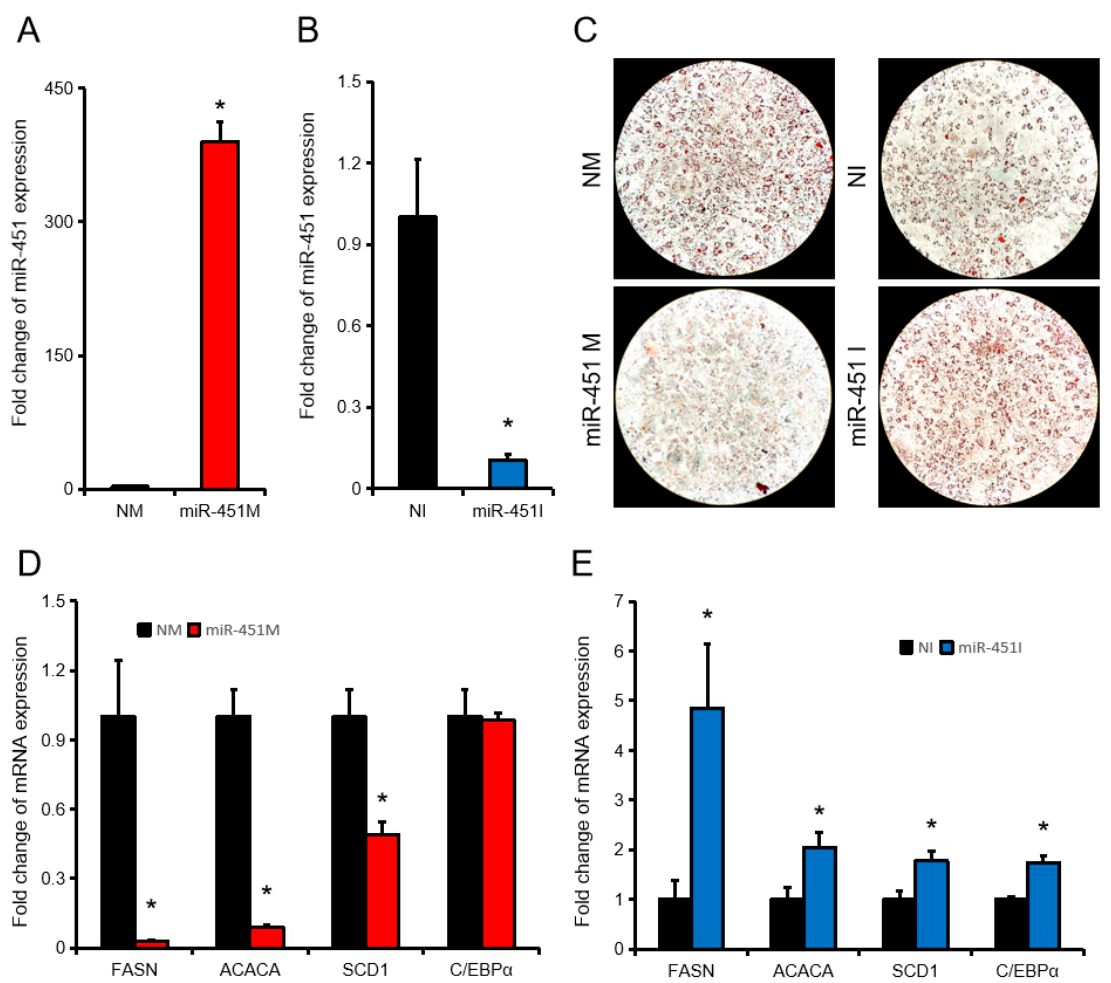
Figure 2. ssc-miR-451 regulates the differentiation of porcine primary adipocytes. ( A , B ) miR-451 expression in porcine primary adipocytes after transfection with miR-451 mimic ( A ) and inhibitor ( B ). ( C ) Oil red staining of porcine primary adipocytes. ( D , E ) The expression of FASN, ACACA, SCD1, and C / EBP α in porcine primary adipocytes after transfection with miR-451 mimic ( D ) and inhibitor ( E ). All results are presented as means ± SEM. n = 3. * p < 0.05.